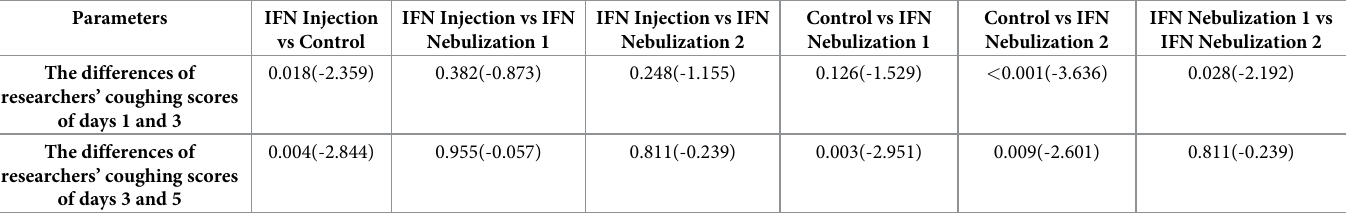
Table 5. The P values of pairwise comparisons for the differences in coughing scores as assessed by the researchers by the Mann—Whitney U test. (Z values in the parenthesis).